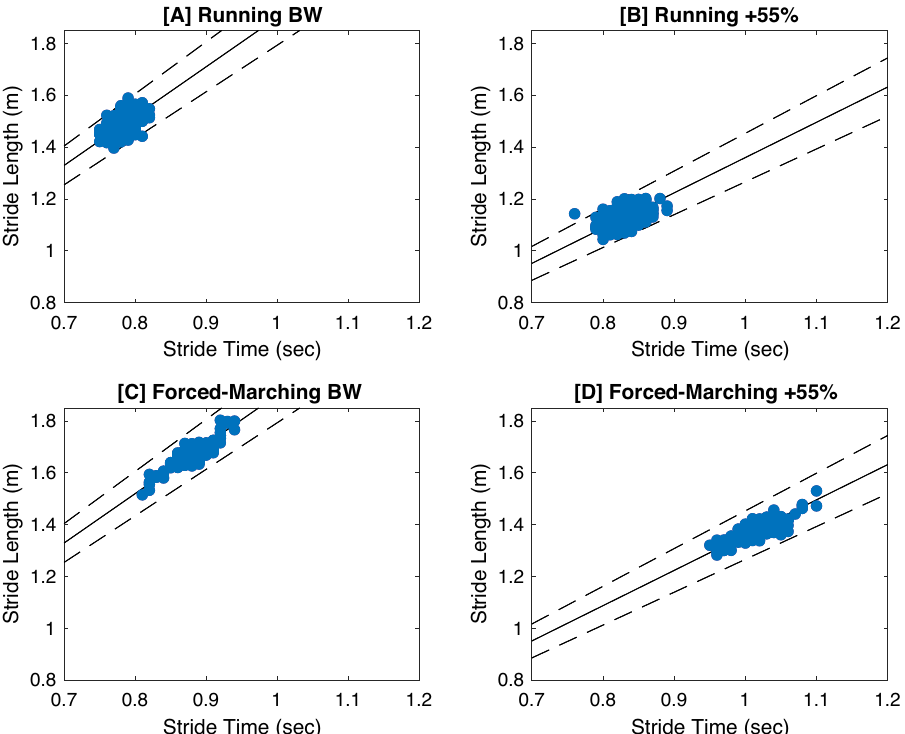
Figure 2. Exemplar GEM Plots. Exemplar GEM plots of a single female participant during the unloaded (BW) and + 55%BW load conditions. The solid line represents the goal manifold where each point on the line is a stride time and stride length combination that achieves the trial velocity. The dotted lines above and below the goal manifold are 5% error bars. Both the natural locomotion conditions of running, ( A ) and ( B ), exhibit a wider spread perpendicular to the goal manifold and have relative variabilities of 1.39 and 1.71 for this participant respectively. Moreover, some of the variations are outside of the ± 5% error bars ( B ). Conversely, the imposed locomotion condition of forced-marching, ( C ) and ( D ), exhibits a wider spread along the goal manifold and have relative variabilities of 2.09 and 2.36 respectively. While forced-marching may result in more stride variations that achieve the task goal of maintaining trial velocity, the larger spread indicates a greater range of coordinative patterns, some of which may be deleterious in